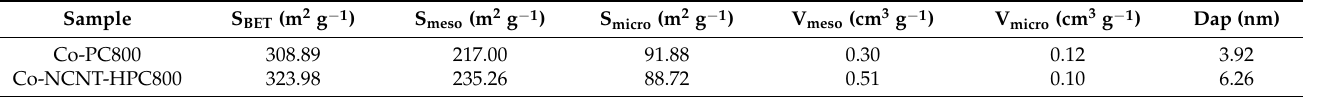
Figure 4. ( a ) Nitrogen adsorption–desorption isotherm and ( b ) pore size distribution of Co-PC800 and Co-NCNT-HPC800. Table 1. Analysis of specific surface area data of Co-PC800 and Co-NCNT-HPC800.